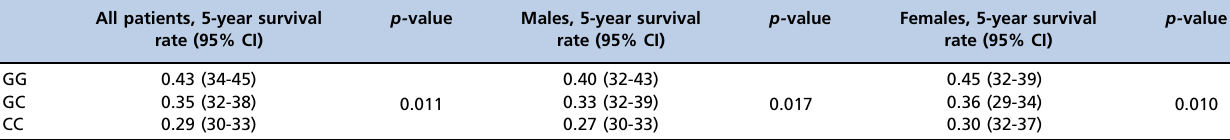
*Adjusted for age, sex, and smoking and family history of cancer in the logistic regression model Table 3 - Relationship between 5-year survival rate and ERCC5 Asp1104His polymorphism status. All patients, 5-year survival rate (95%